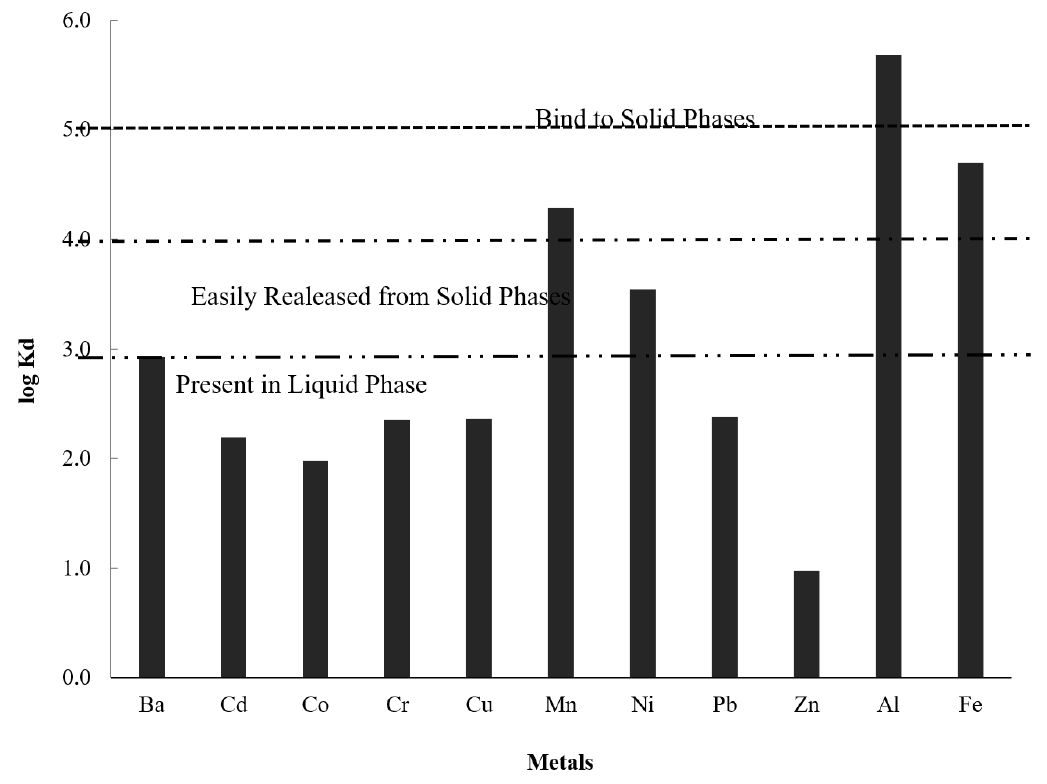
Figure 6. Partition Coefficients (log Kd) results for water and sediment samples.